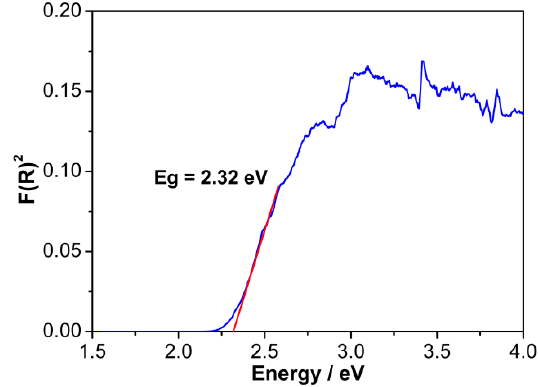
Figure 4. Plot of F (R) 2 vs. photon energy for 1 .